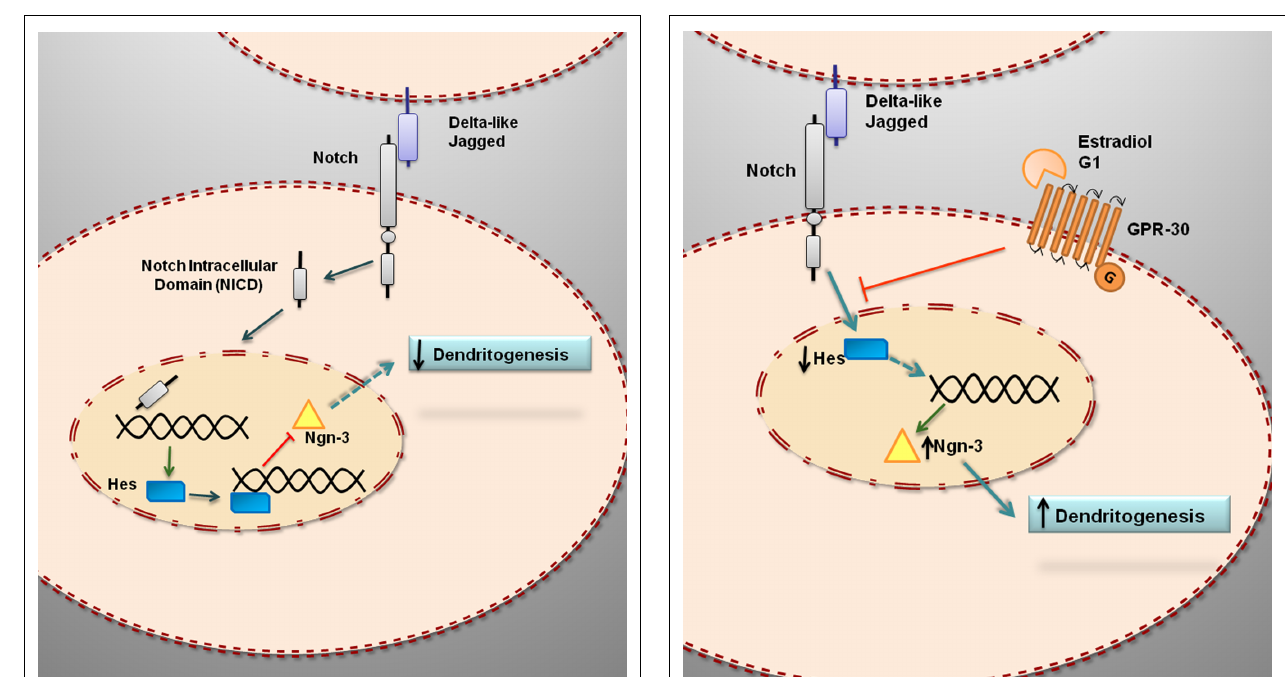
hippocampal slice cultures (Bender et al., 2010). This